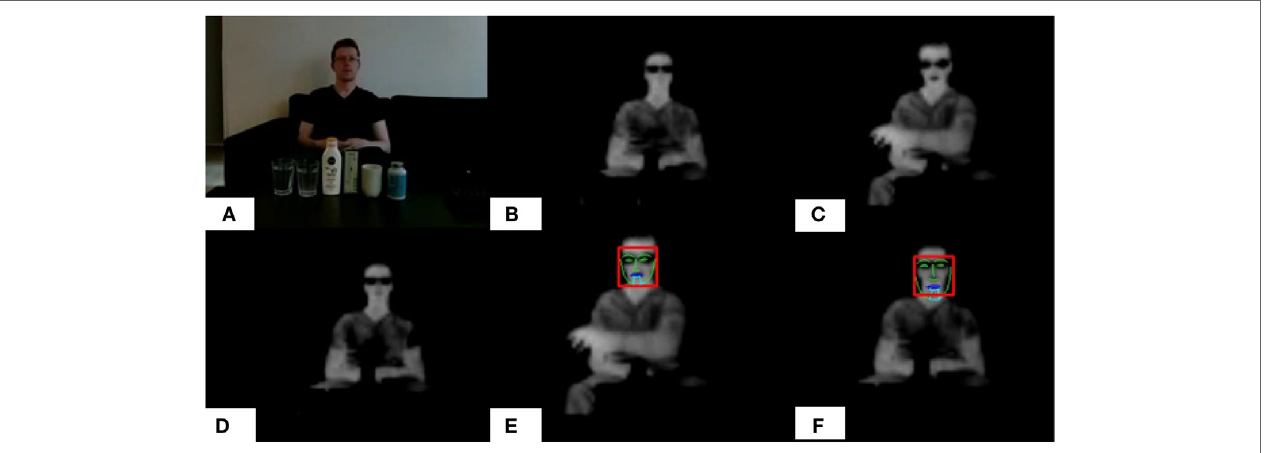
FigUre 9 | Detecting drinking. (a) RGB image of setup with a human and some objects. (B) Thermal image before drinking (c) Thermal image after drinking, (D) Thermal image 30 s after drinking, (e) processed thermal image, indicating face rectangle (red), face outline (green), lips area (blue), and area below the lips (cyan), and (F) a model for normal face length was used to avoid some failed detections which detected a mouth at the person’s chin. Consent has been obtained from the individual depicted (the first author) for the publication of this